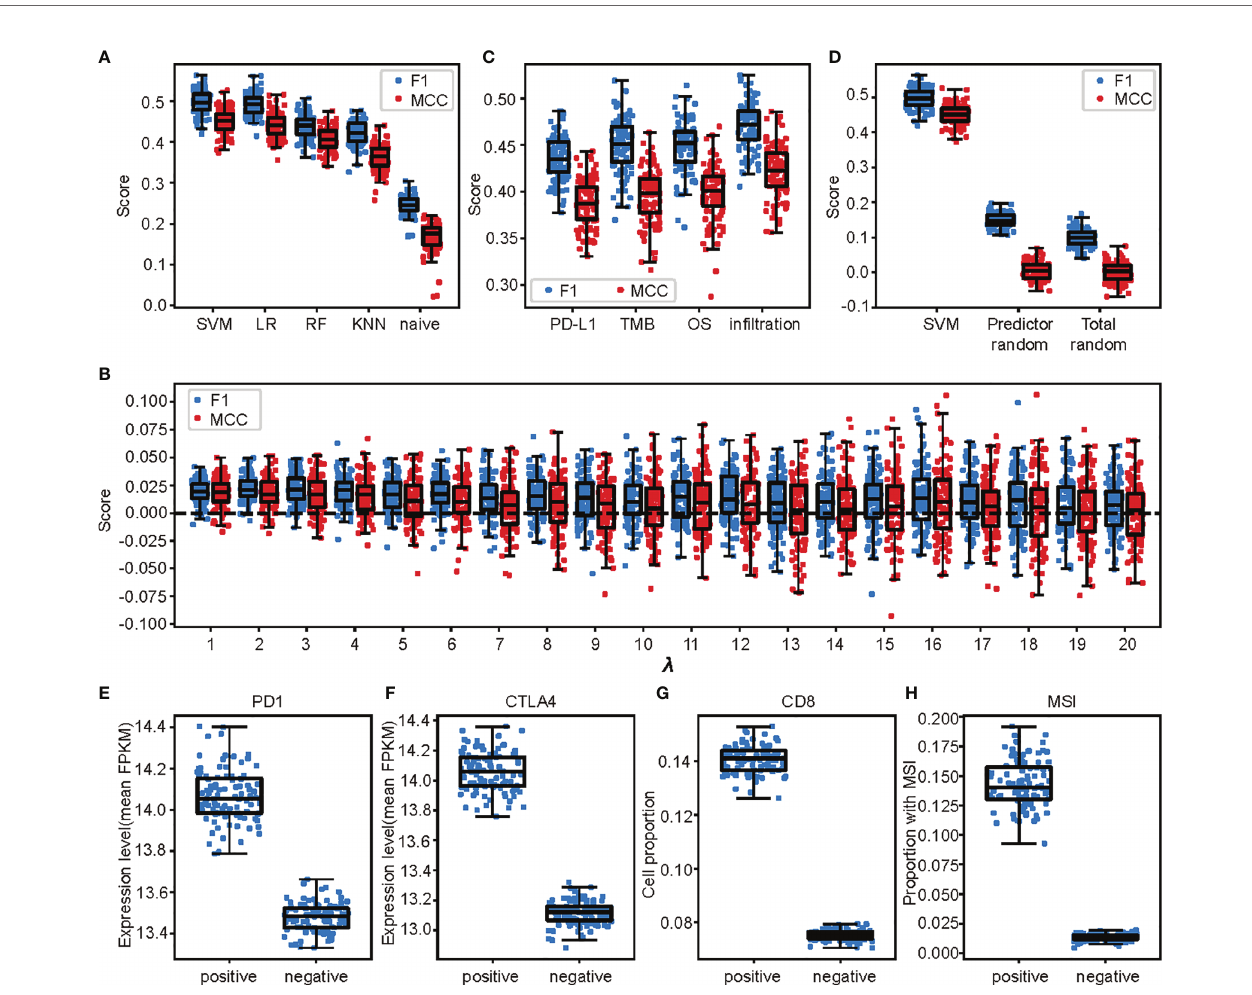
FIGURE 3 | The responsiveness of cases to ICI treatment were predicted by the selected probes. (A) The SVM model outperformed the other models when the performances were measured by F 1 score or MCC score. (B) The SVM model performances when only probes selected by single indicator involved. (C) Differences of the model performances between SVM models trained from the selected probes and random chosen controls among all super-parameter l s searched in the cross-validation step of the model building. In each comparison, samples were randomly split into 80% training and 20% testing set. (D) Comparisons between performances of the trained models and those when the respondent (responsiveness) of the samples were randomly shuf fl ed. “ Predicted random ” meant the predicting performance of SVM models with same setting when the respondent was shuf fl ed. “ Total random ” meant direct measurement of the similarity of respondents before and after shuf fl ing when the similarity was measured by F 1 score or MCC score. (E – H) Differences of biomarkers for ICI treatment responsiveness which is independent with those used in model build for the cases predicted as positive and negative in the 100 random test sets. Each point represented the average value in one test